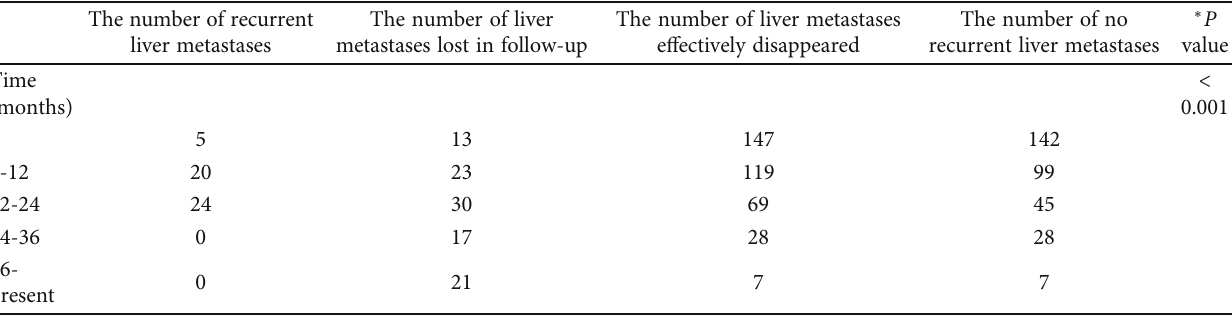
Table 2: The correlation of time nodes and